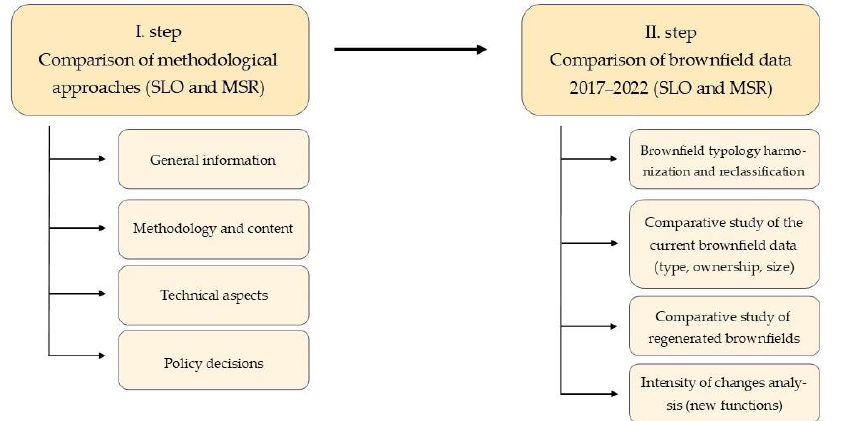
Figure 2. Methodological framework. Prepared by the authors.